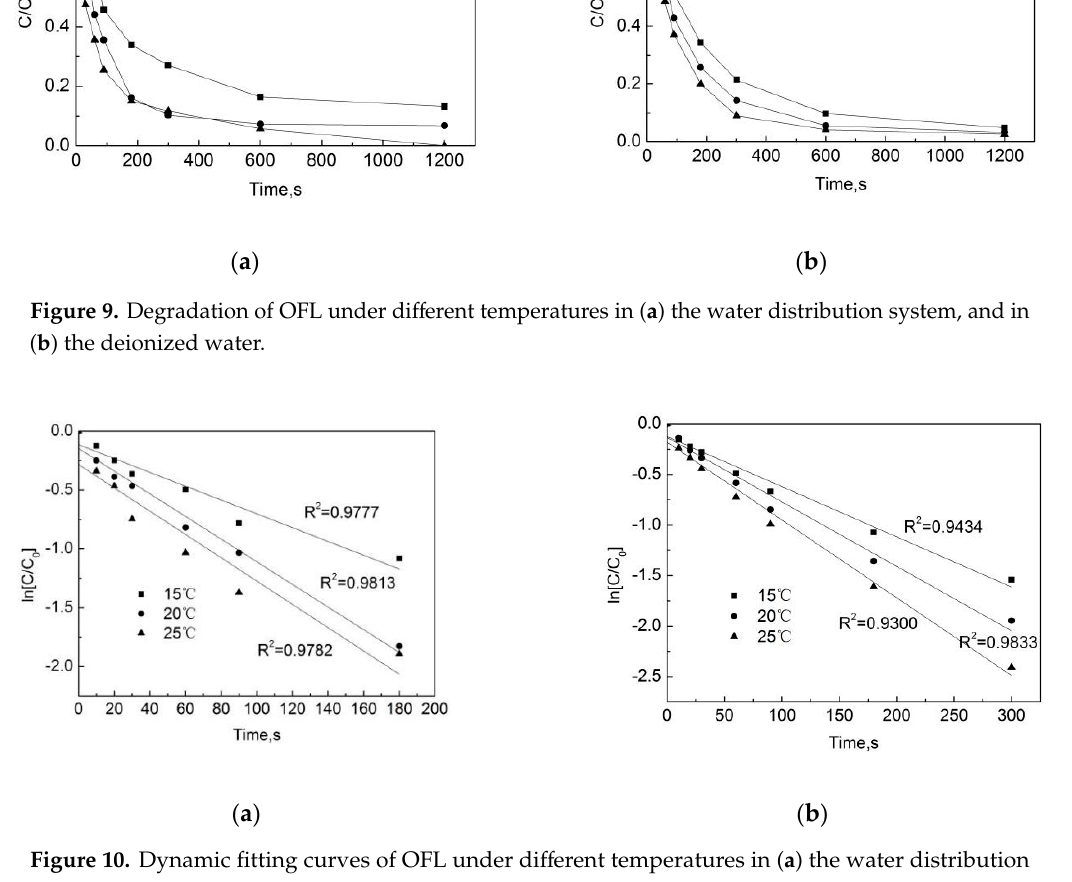
Figure 10. Dynamic fitting curves of OFL under different temperatures in ( a ) the water distribution system, and in ( b ) the deionized water.